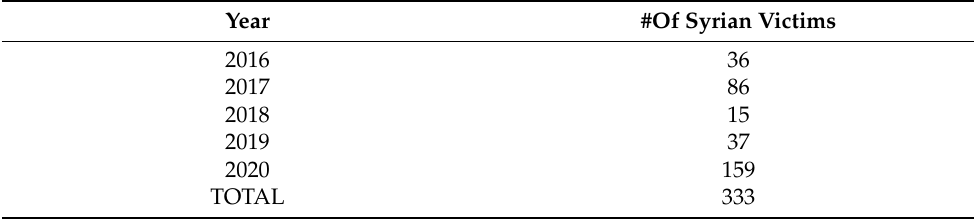
Table 1. The Number of Detected Syrian Victims of Trafficking per Year in Turkey.